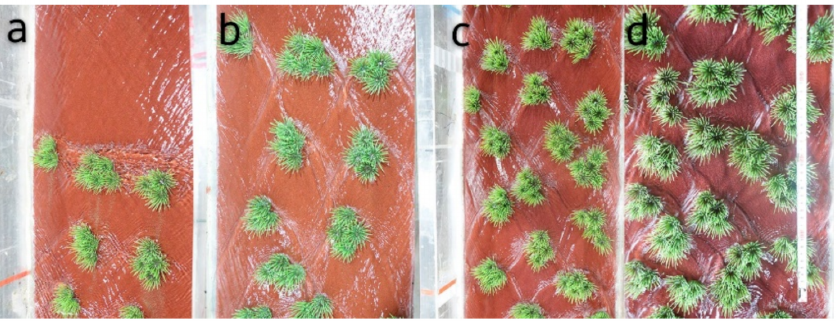
Figure 11. The process of vegetation being submerged for ( a ) 9.76%, ( b ) 19.97%, ( c ) 47.66%, and ( d ) 66.42% vegetation